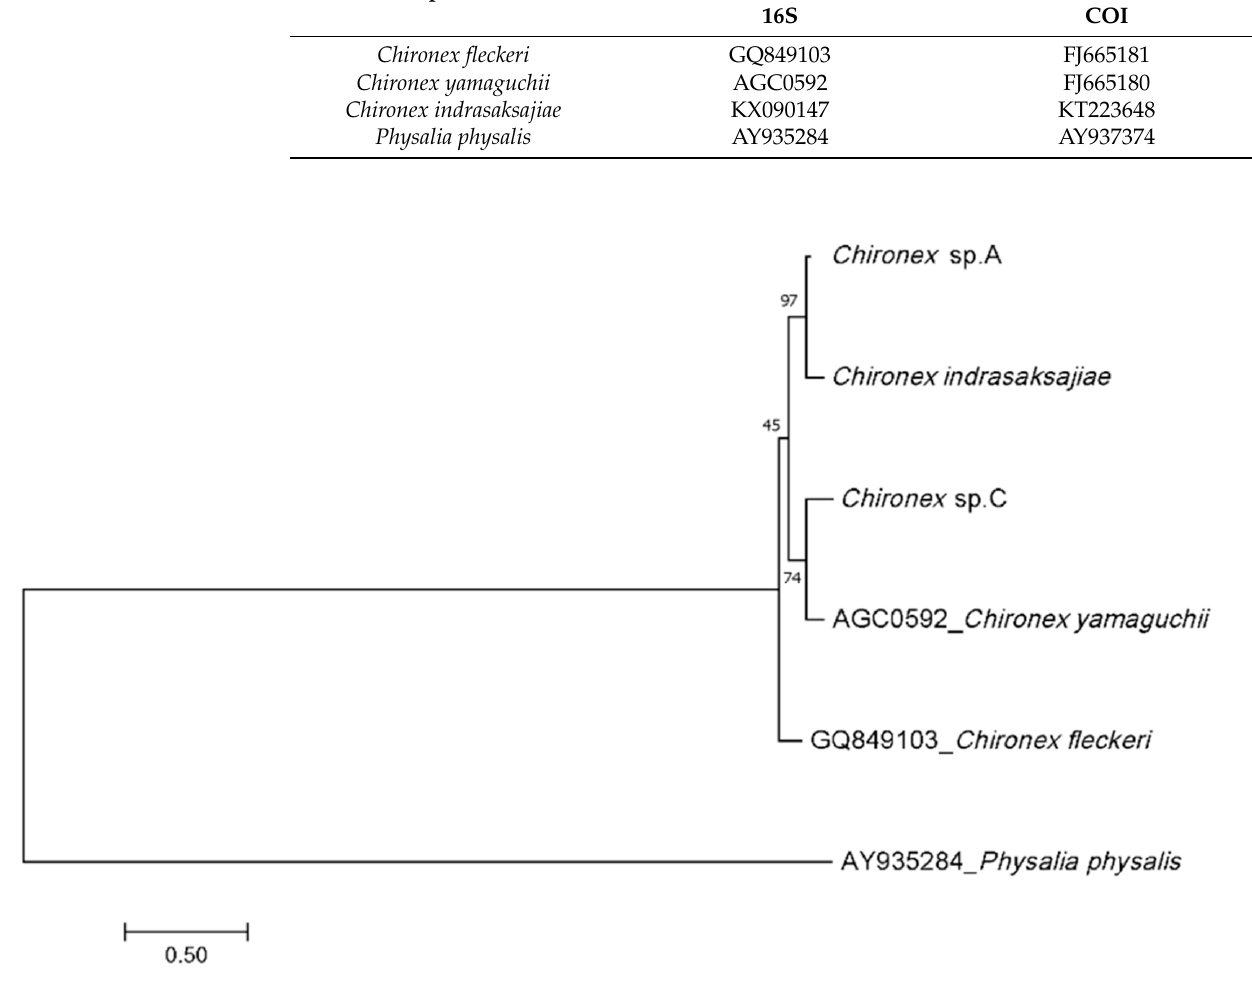
Table 2. The information of 16S rRNA and cytochrome oxidase subunit I (COI) gene sequences from GenBank. Accession No. Species 16S COI